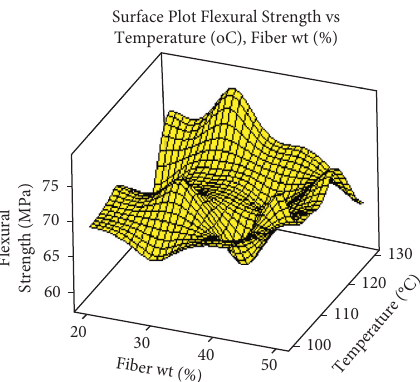
Figure 11: Flexural strength: surface plot of fiber weight percentage and temperature.